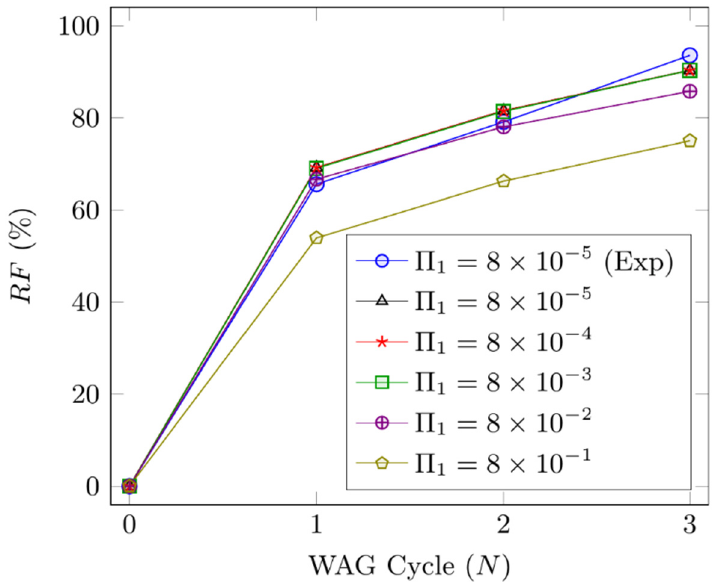
Figure 9. Effect of oil inverse capillary number ( π 1 ) on the RF of the WAG injection using the GEP correlation.